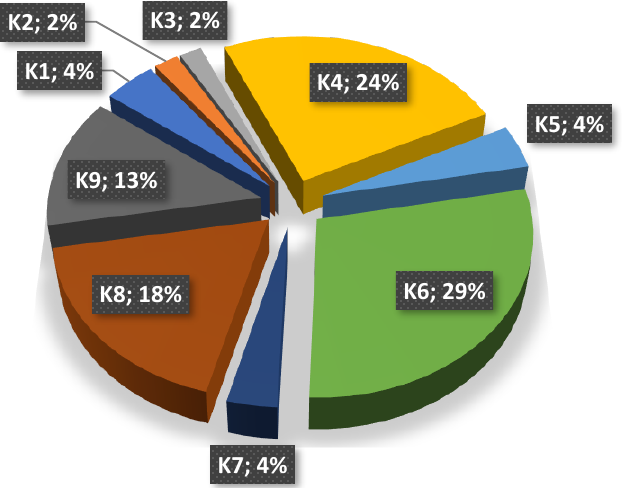
Figure 4. Weighted criteria expressed as percentages, according to Expert 1.